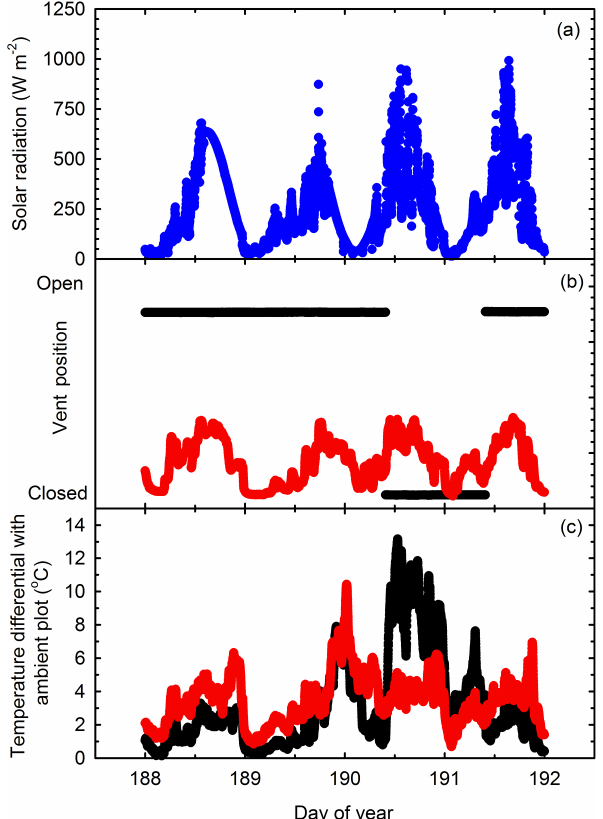
Figure 4. A 4-day sample time series of data demonstrating how the ZPW chamber can modulate the air temperature inside a chamber: (a) shows ambient solar radiation; (b) shows the degree of active venting by the ZPW chamber (red symbols) and the position of the fixed vent on the control chamber (black); (c) shows the air temper- ature differential between the ZPW chamber and the ambient plot (red) and the control chamber and the ambient plot (black).